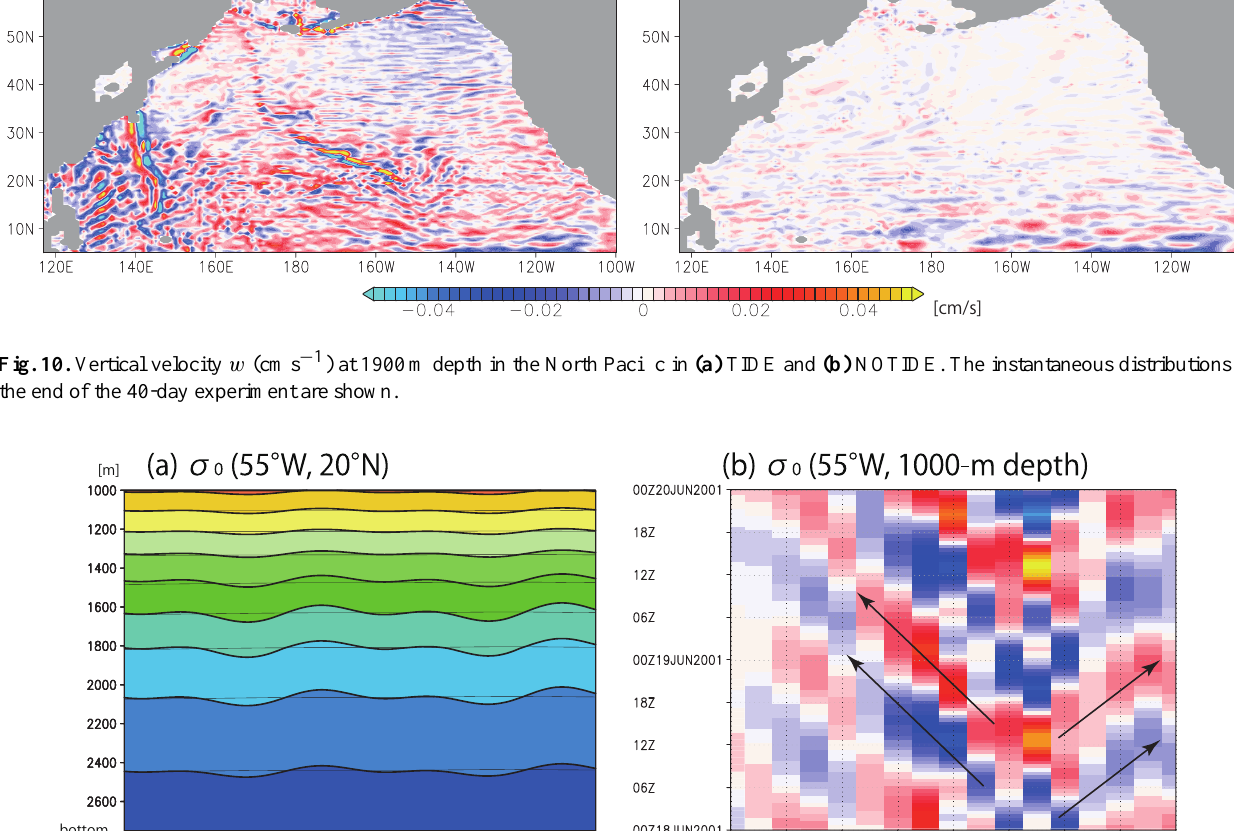
at 0 [kg m − 3 ] from bottom to the 1000-m depth at 0 at 55 ◦ W, 1000-m depth in TIDE. The 0